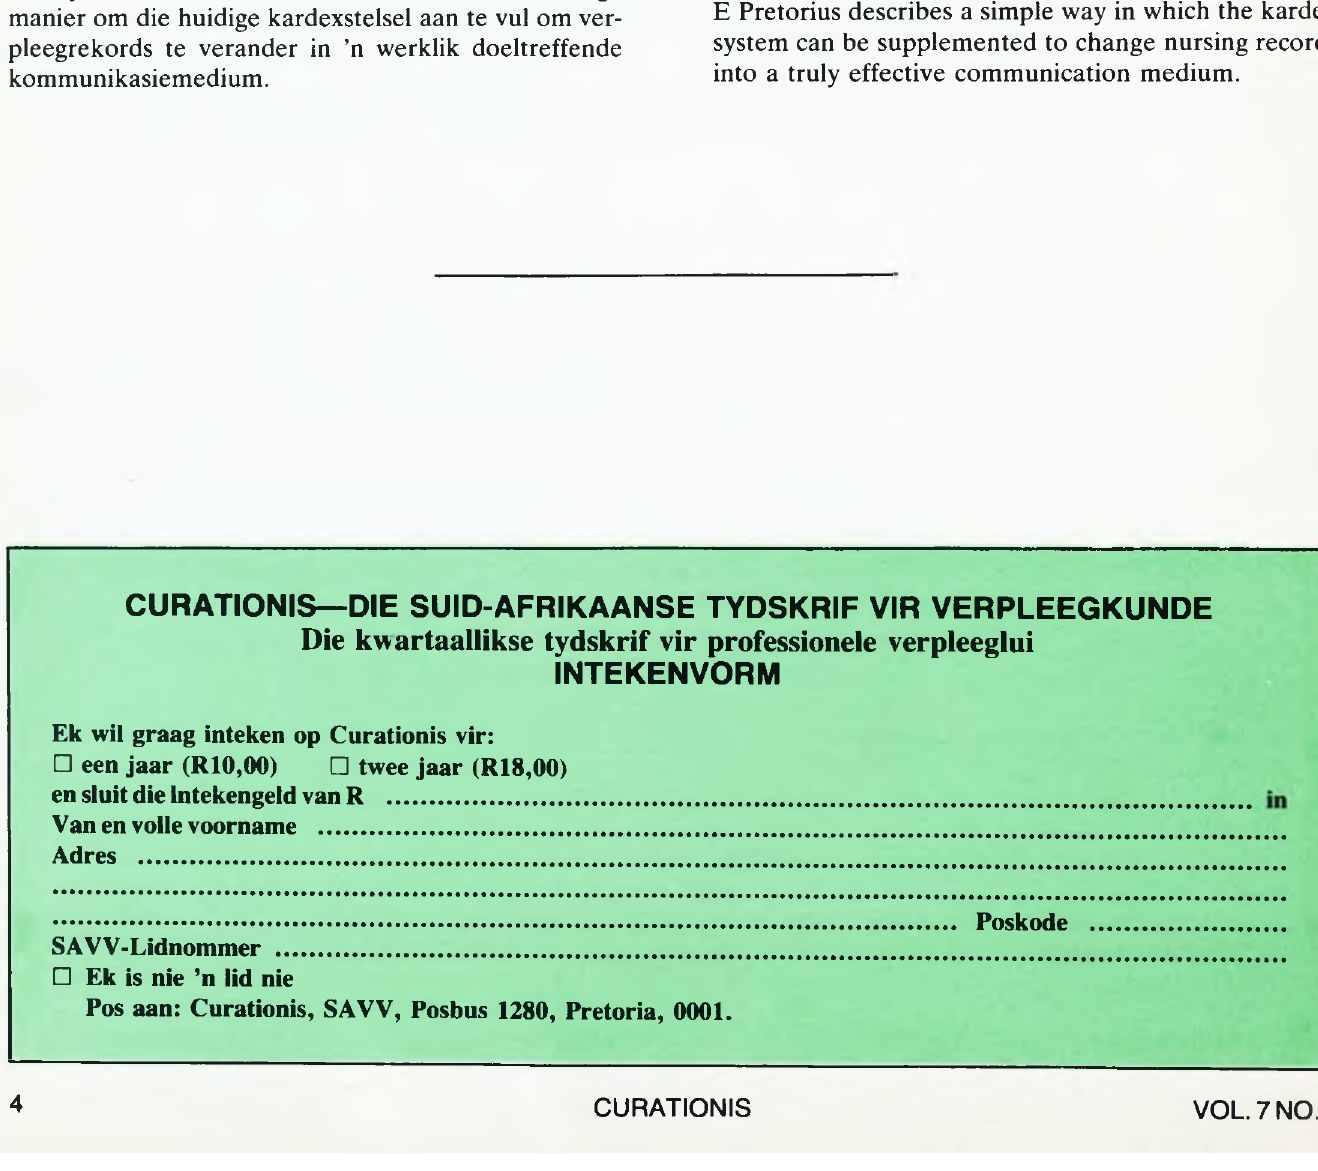
CURATIONIS— DIE SUID-AFRIKAANSE TYDSKRIF VIR VERPLEEGKUNDE Die kwartaallikse tydskrif vir professionele verpleeglui